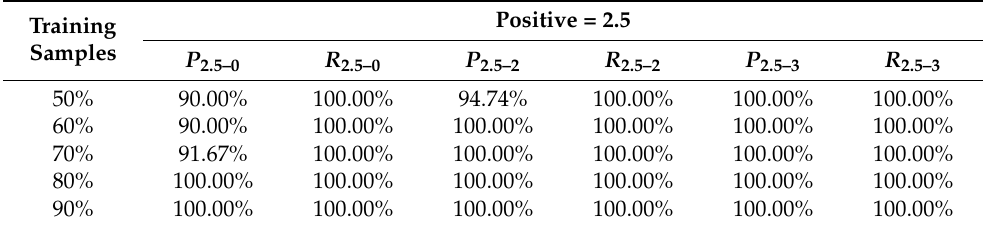
Table 6. Inter-class precision and recall of HY = 2.5 as positive.